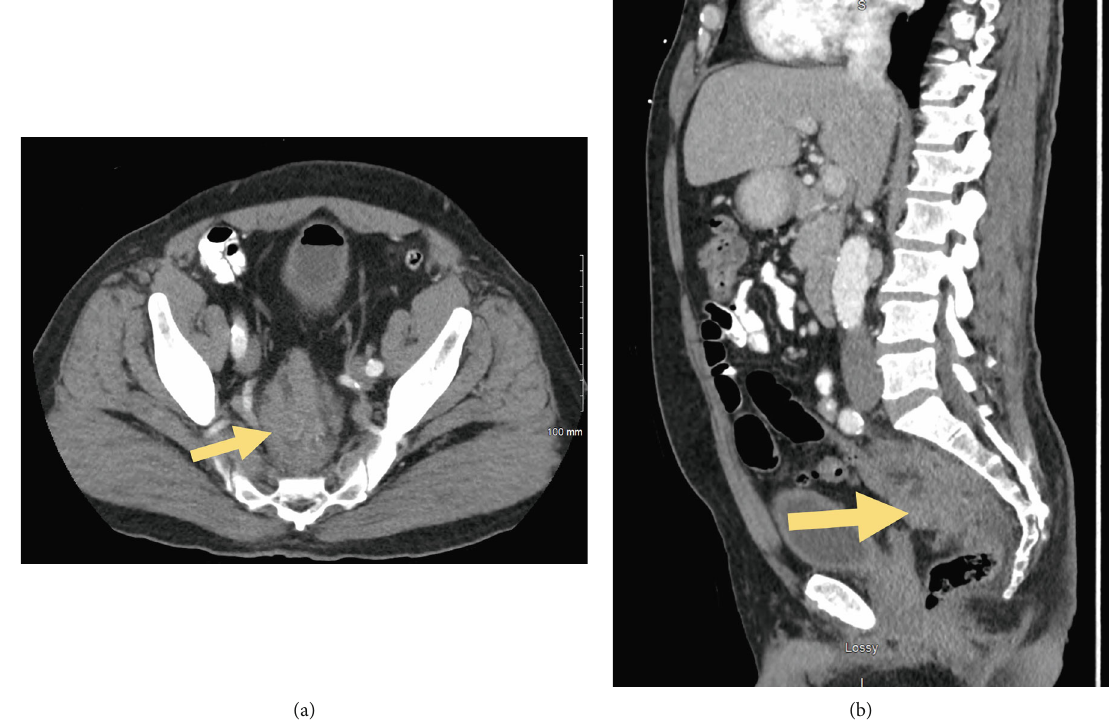
Figure 2: (a) Axial abdomen/pelvis CT showing a soft tissue mass (arrow) inseparable from the rectal wall. (b) Sagittal abdomen/pelvis CT showing a soft tissue mass (arrow) inseparable from the rectal